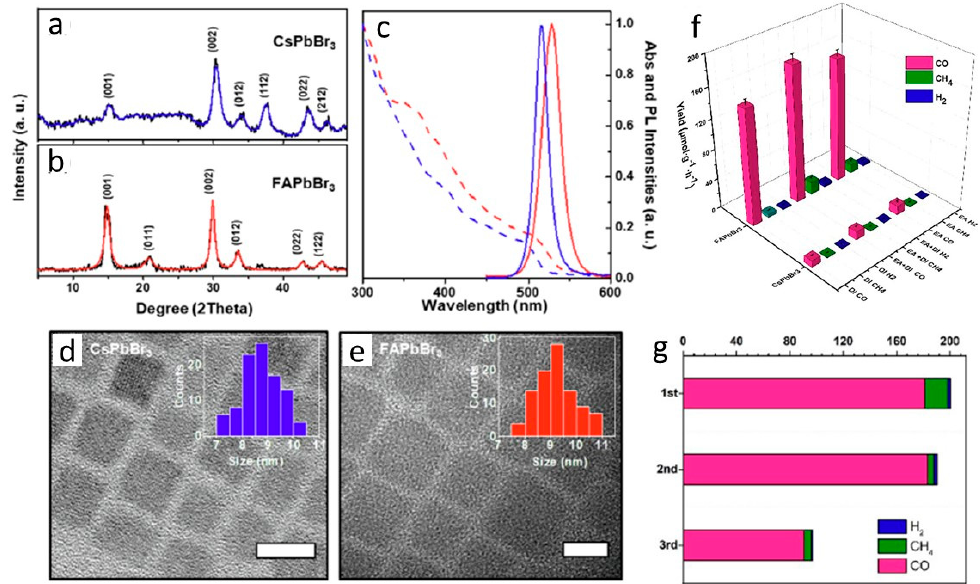
Figure 7. ( a,b ) The XRD patterns, ( c ) UV-Vis / PL spectra and ( d , e ) TEM images of FAPbBr 3 , and CsPbBr 3 , ( f ) Results of comparative photocatalytic CO 2 reduction in FAPbBr 3 and CsPbBr 3 , and ( g ) reusability test of FAPbBr 3 . Reproduced from [94], with permission from Elsevier, 2020.